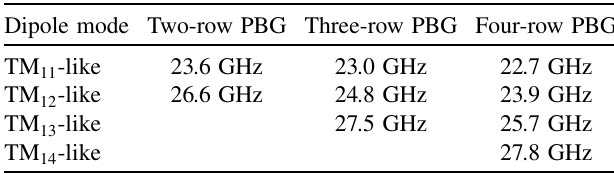
TABLE III. Dipole modes frequency of different row PBGs.